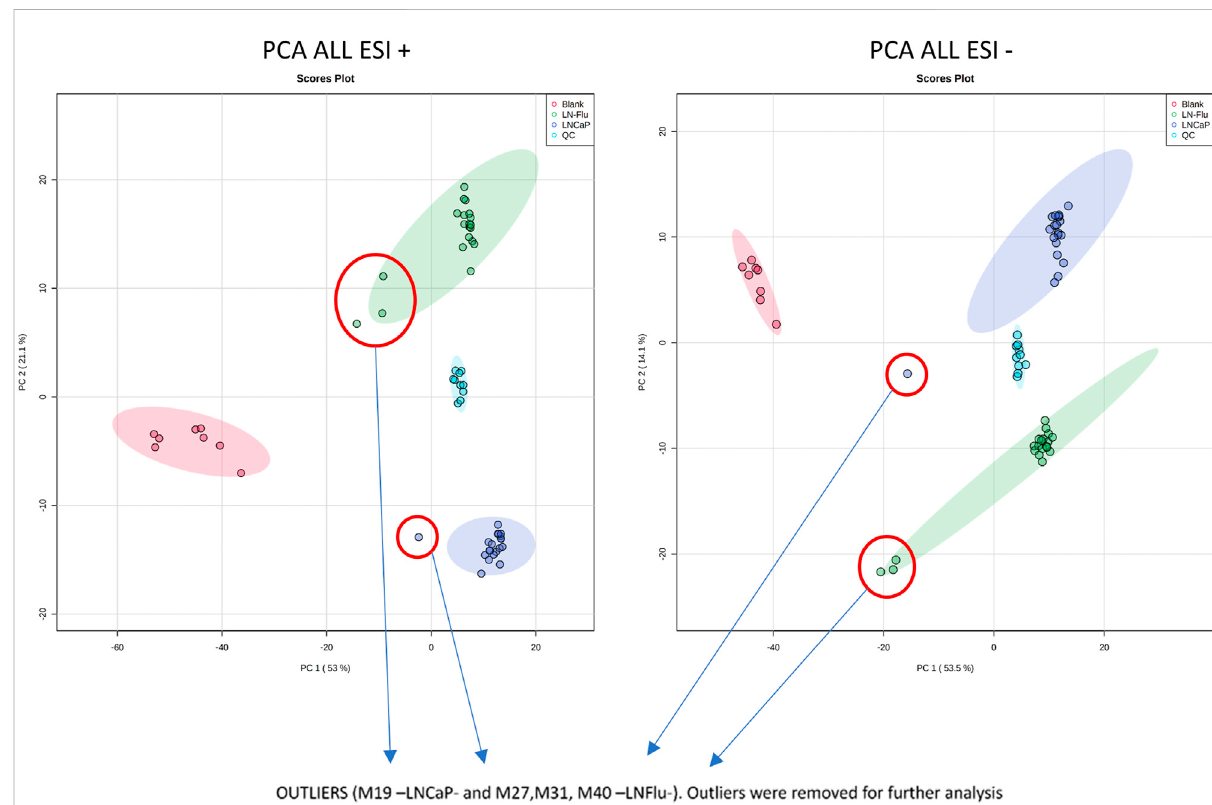
FIGURE 2 The Principal Component Analysis of metabolomic data from all samples in both positive and negative MS ionization methods shows good separation between group classes. Blank samples (red dots) are perfectly separated from the rest, and QC samples (light blue dots) are placed in between LNFlu (green dots) and LNCaP (dark blue dots) samples showing good consistency in the metabolomic